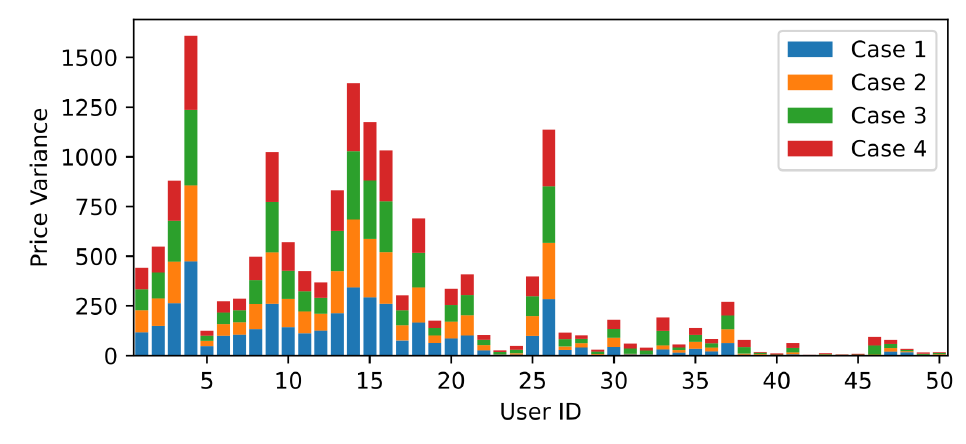
Figure 7. Users price